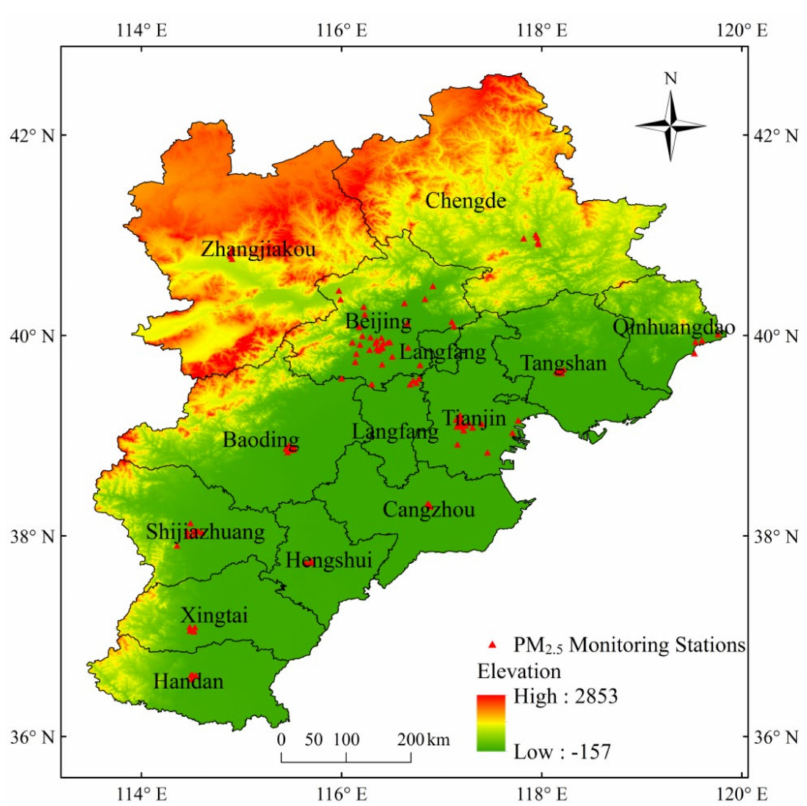
Figure 1. Distribution of PM 2.5 monitoring stations over the Beijing-Tianjin-Hebei